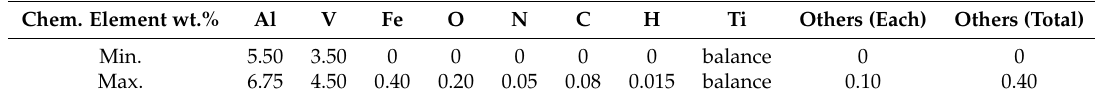
Table 1. Chemical composition of